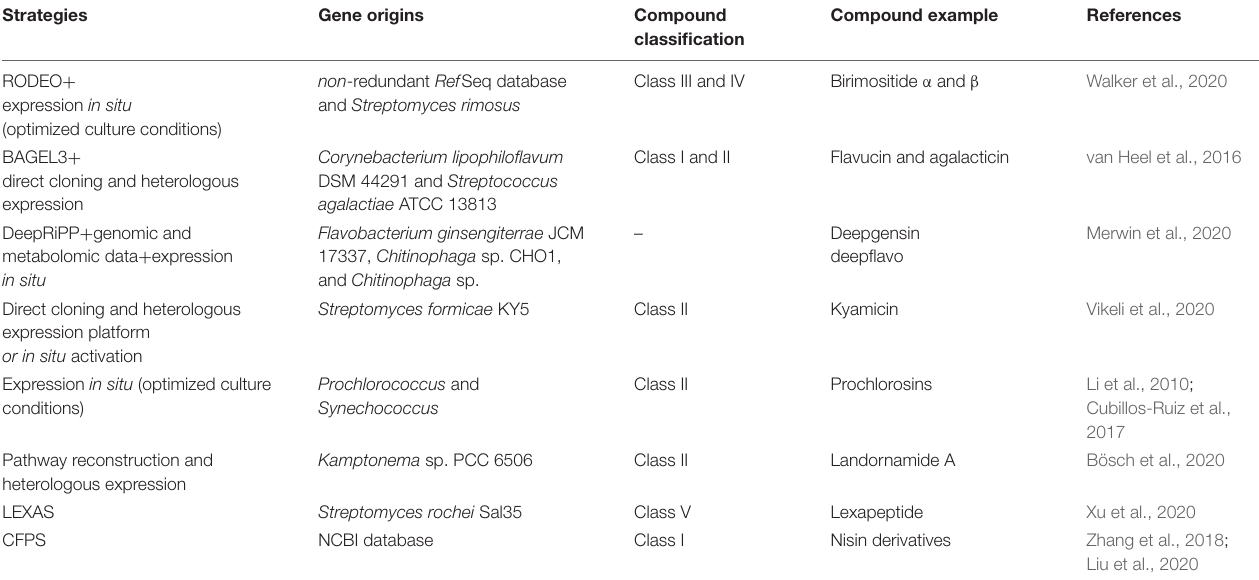
TABLE 2 | Strategies for mining of